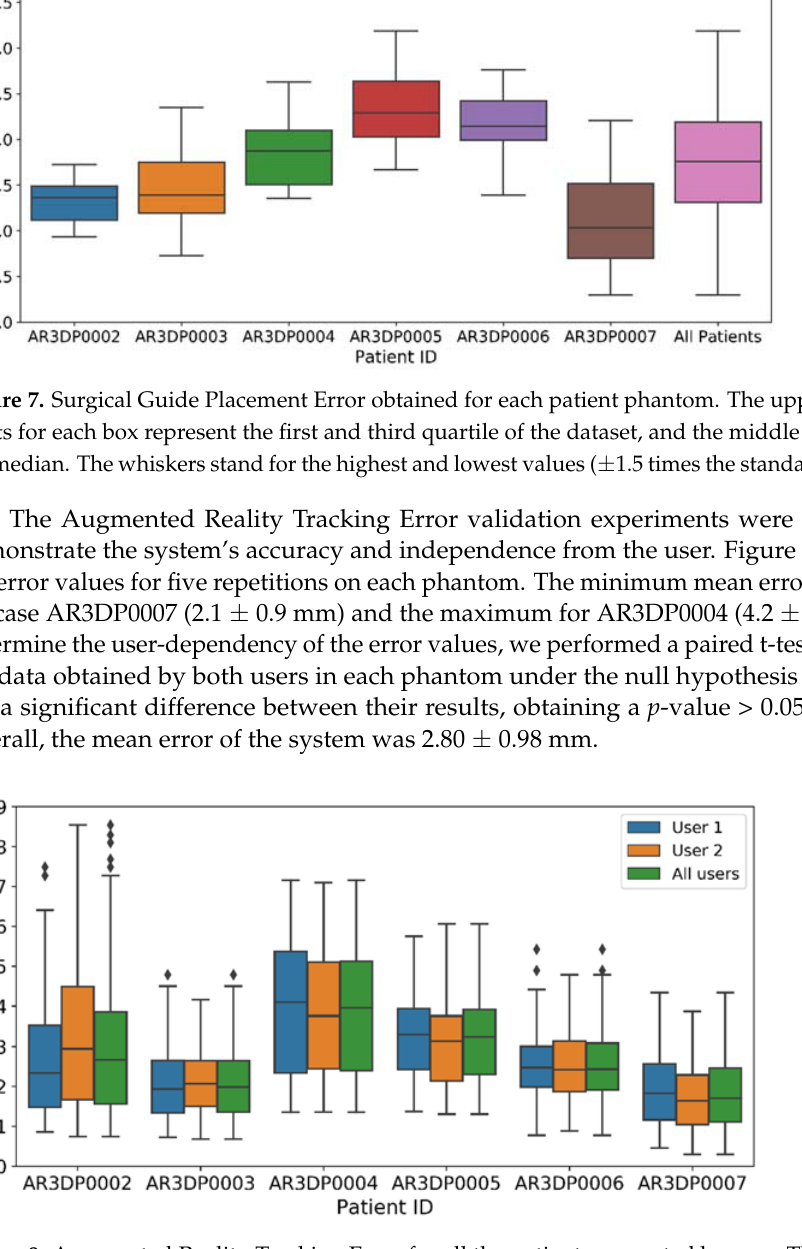
Figure 8. Augmented Reality Tracking Error for all the patients separated by user. The upper and lower limits for each box represent the first and third quartile of the dataset, the middle line indicates the median. The whiskers stand for the highest and lowest values (±1.5 times the standard devia- tion).